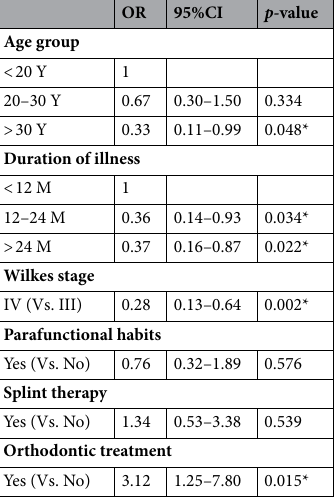
Table 5. Ordered multivariate analysis (unadjusted) with prognostic variables and surgical outcomes of the TMJ arthroscopic discopexy. The parallel assumption hold ( p = 0.100 > 0.05). OR Odds ratio, CI Confidence interval, Y years, M months. *Statistically significant.